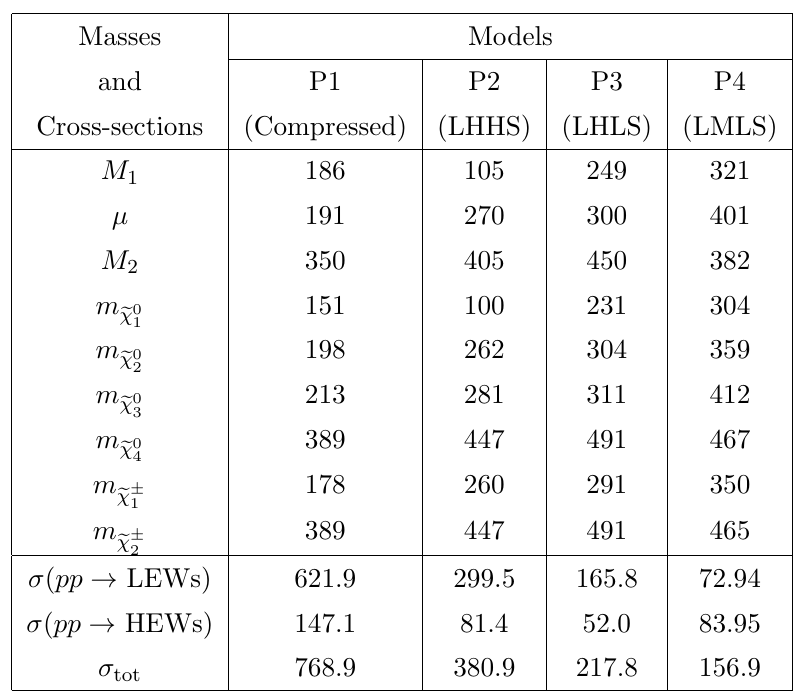
Table 1 . Mass parameters, physical masses and production cross-sections of EWeakinos for four representative points in di(cid:11)erent models introduced in section 2. See text for the details. All masses and mass parameters are in GeV. Cross-sections are in fb